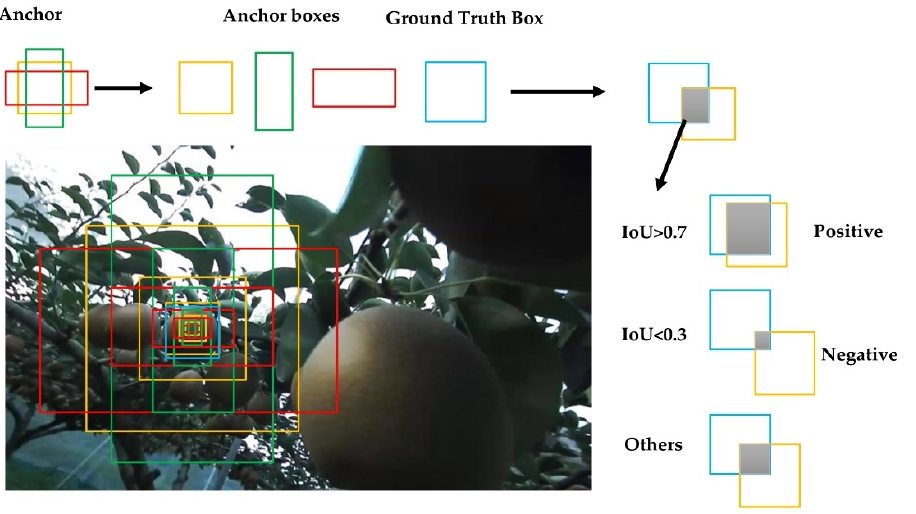
Figure 7. Generation for I o U by comparing anchor boxes with ground truth boxes. If IoU > 0.7, then label = 1 positive; if IoU < 0.3, then label = − 1 negative; others, label = 0.